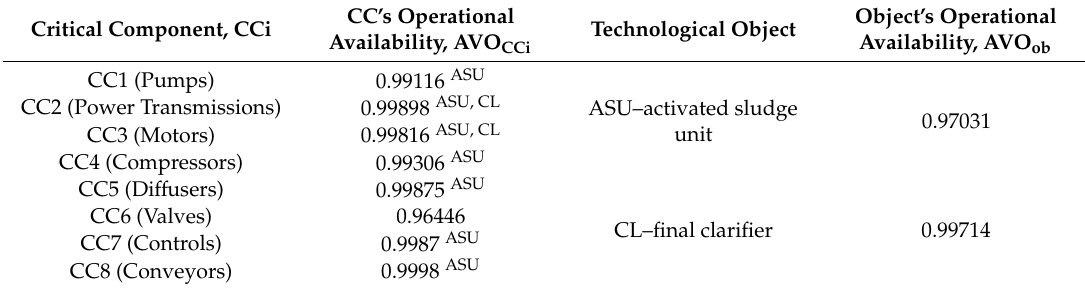
Table 2. Operational availability of critical components (US EPA, [6]) and technological objects of analyzed system.